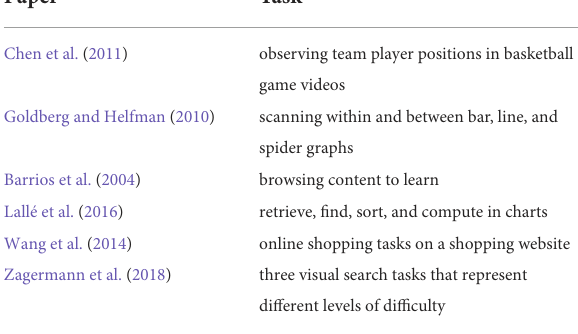
TABLE 8 The tasks in the